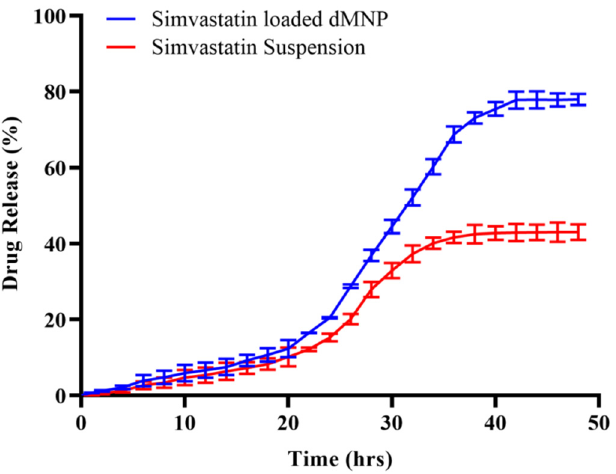
Table 4. Release results of reported dMNPs.